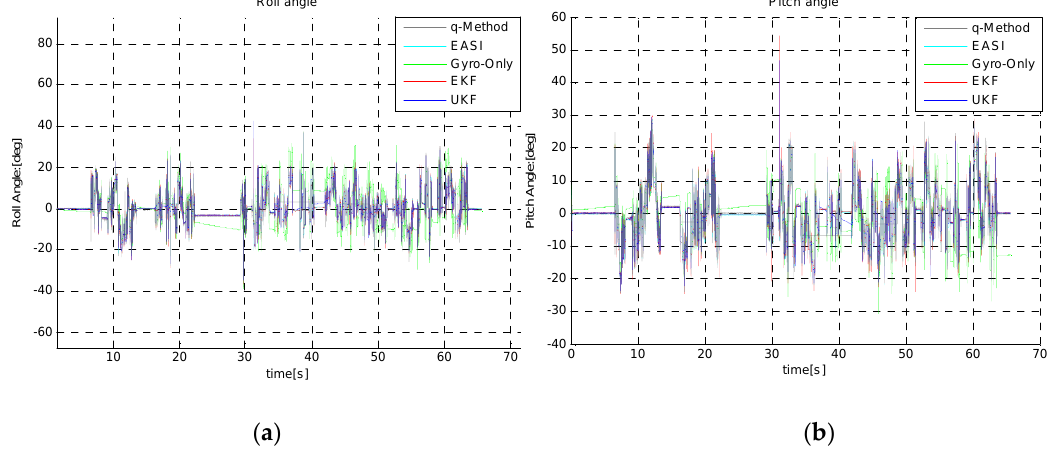
Figure 19. ( a ) Roll angle and ( b ) pitch angle estimation during the long dynamic test.